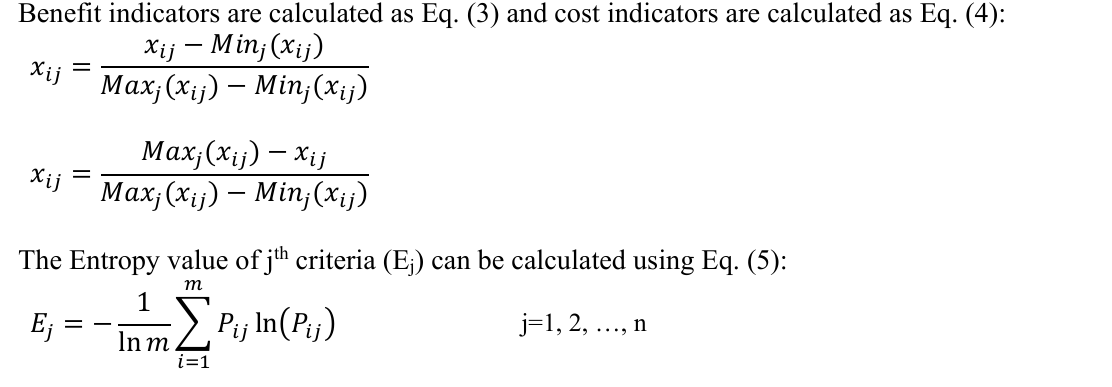
A decision matrix table with m alternatives and n criteria Alternatives